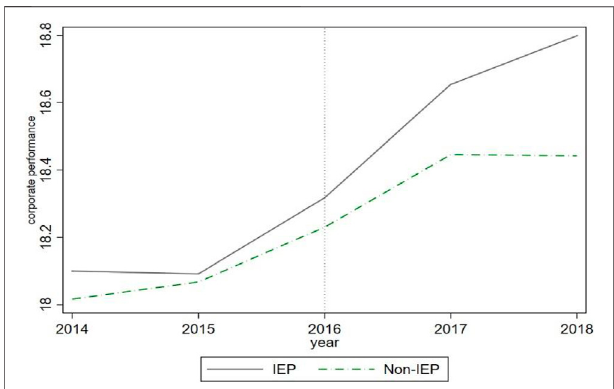
FIGURE 2 | Corporate performance change trend. Note: IEP stands for treatment group and Non-IEP stands for control group.